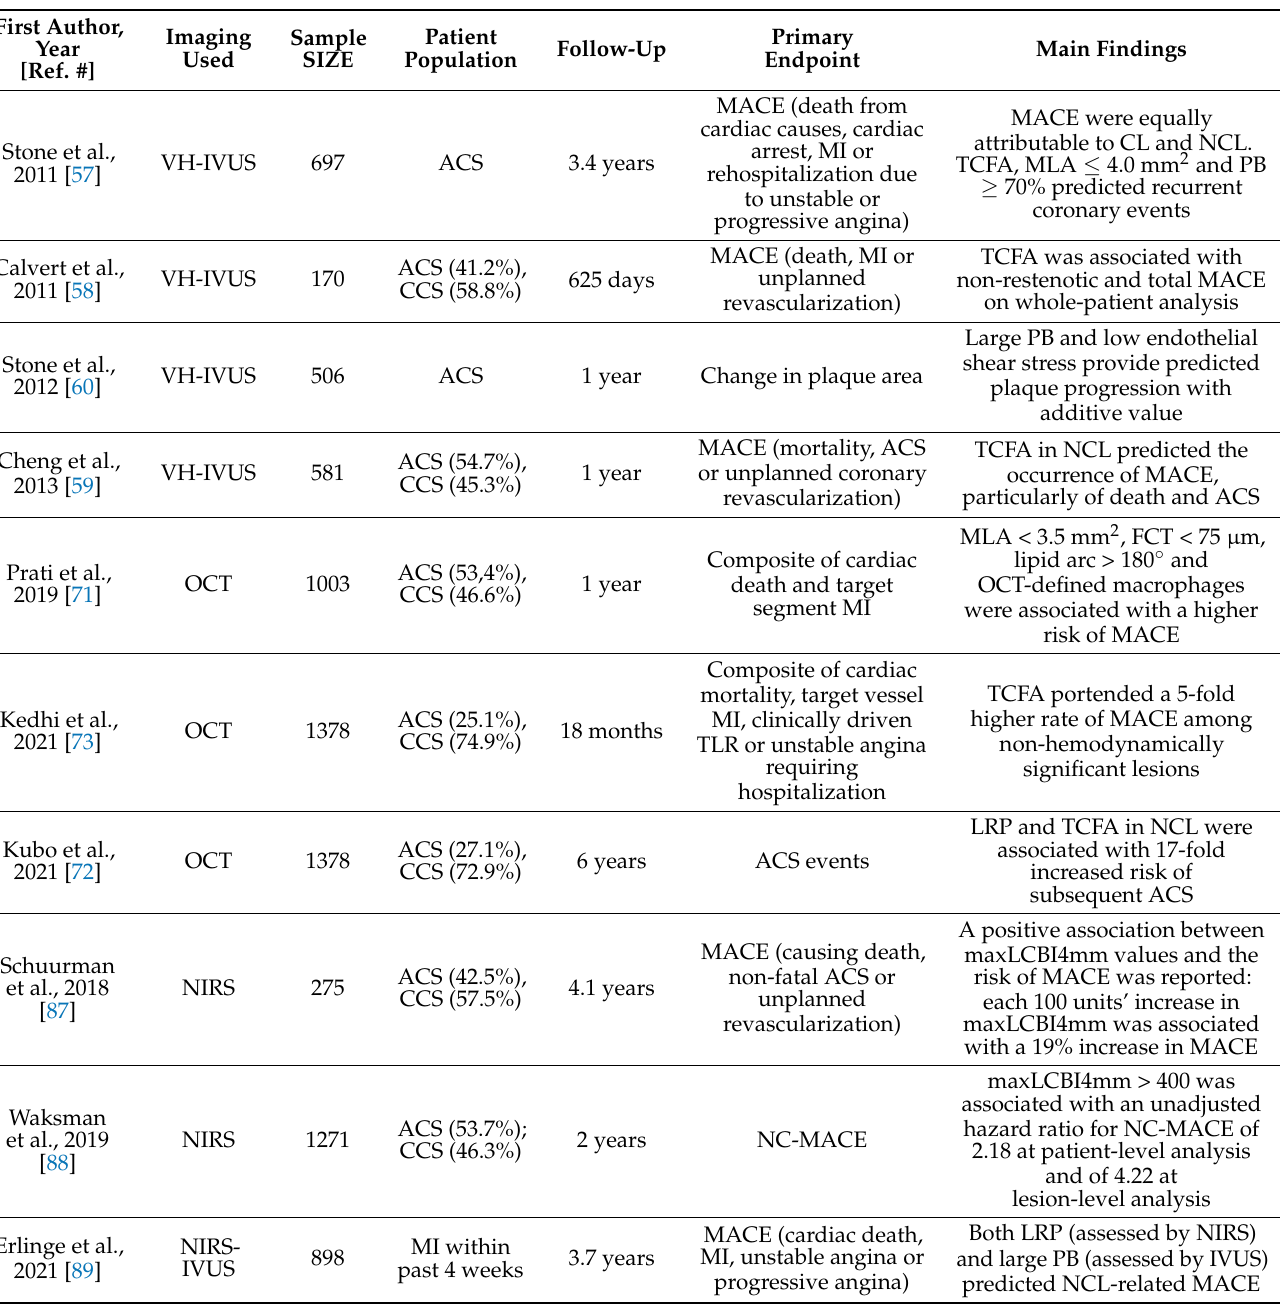
Table 1. Summary of major studies addressing the prognostic role of coronary plaque composition assessment by intracoronary